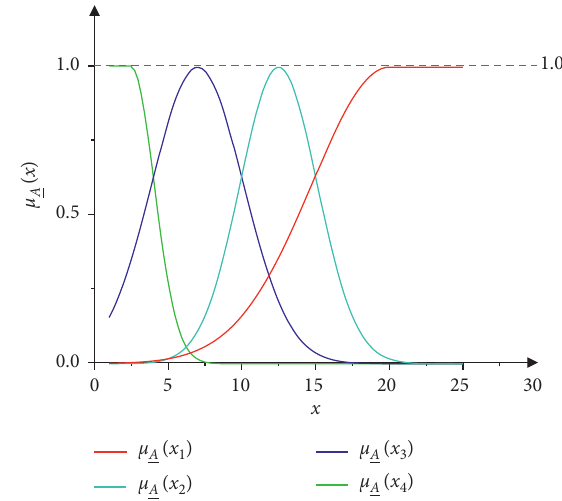
Figure 2: Curve distributions of risk grade membership